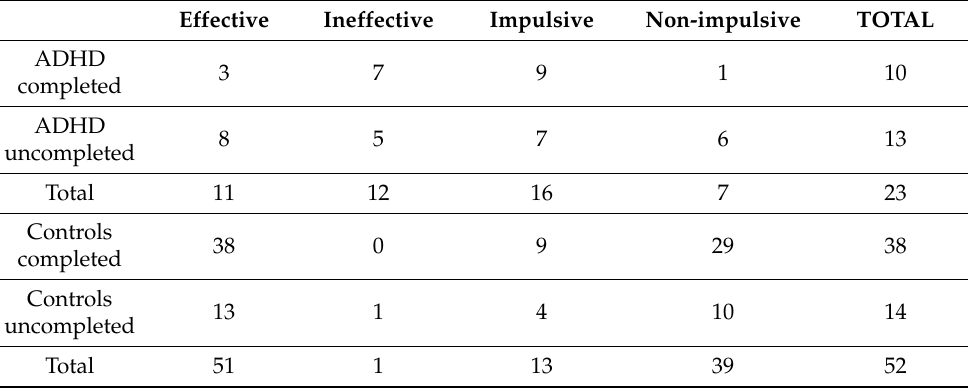
Table 2. Effectiveness and impulsivity in the subdivision of the ADHD and control groups in the completed and uncomplete